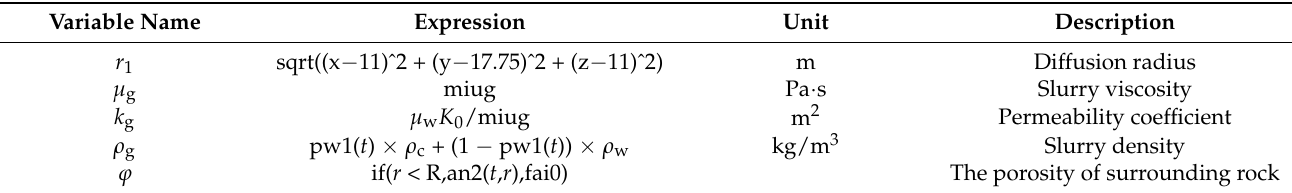
Table 2. Model variable